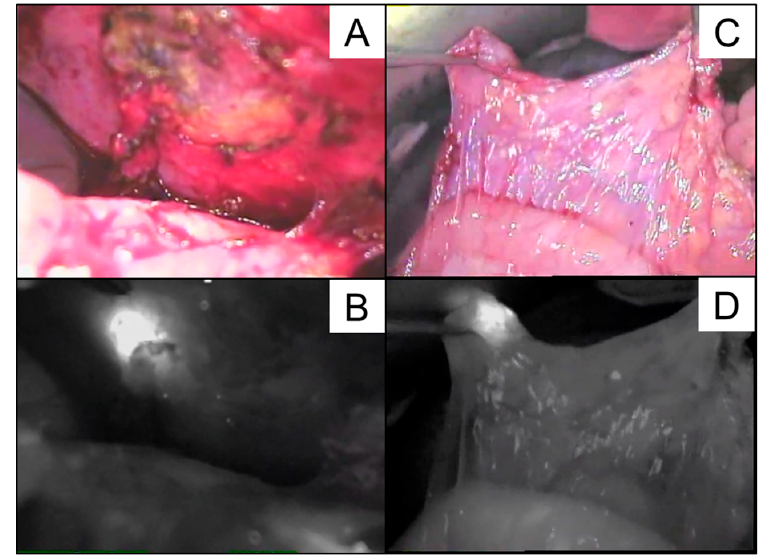
Figure 3. White-light mode ( A , C ) and corresponding near-infrared mode ( B , D ) findings in the peritoneal cavity at the time of the second laparotomy after the first LDLTx procedure are shown, macroscopic image.